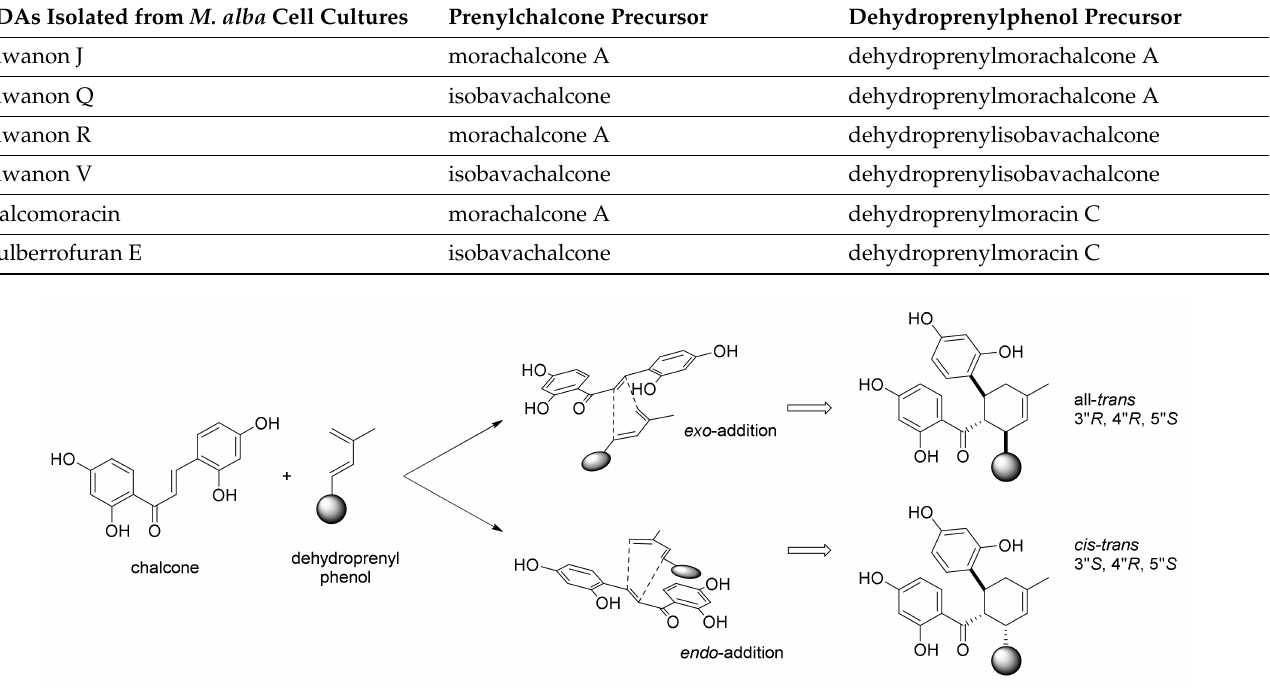
Figure 7. Key biosynthetic [4+2] cycloaddition and absolute configuration of all- trans and cis-trans